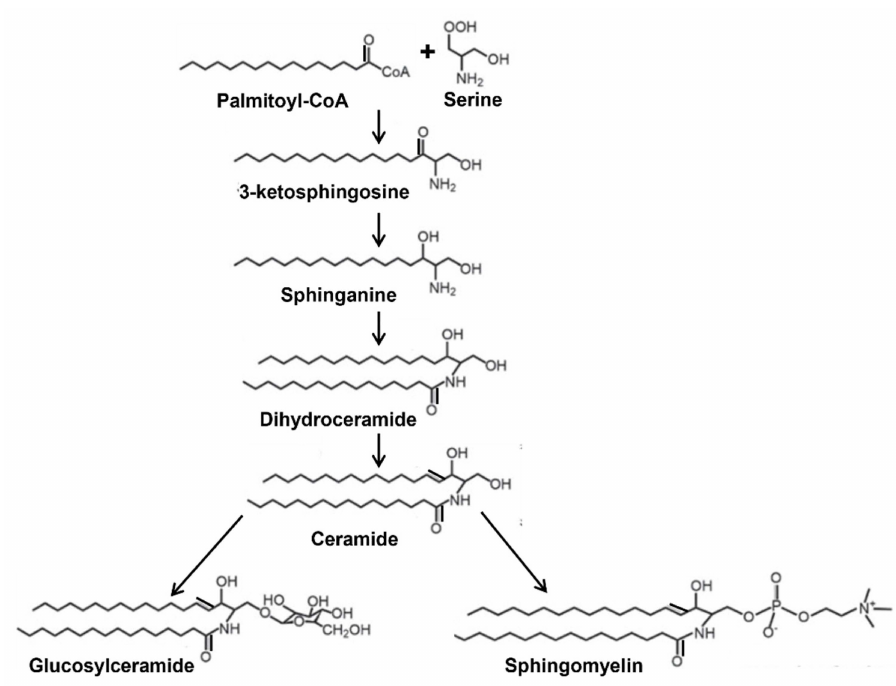
Figure 1. Simplified schematic representation of the synthesis of glucosylceramide and sphingomyelin from